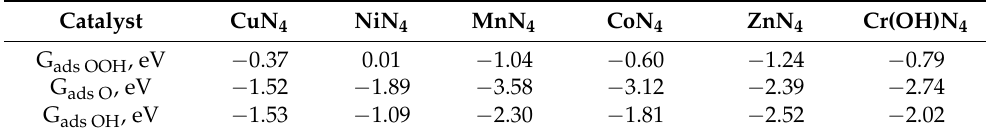
Table 2. Relative energies of adsorption intermediates.